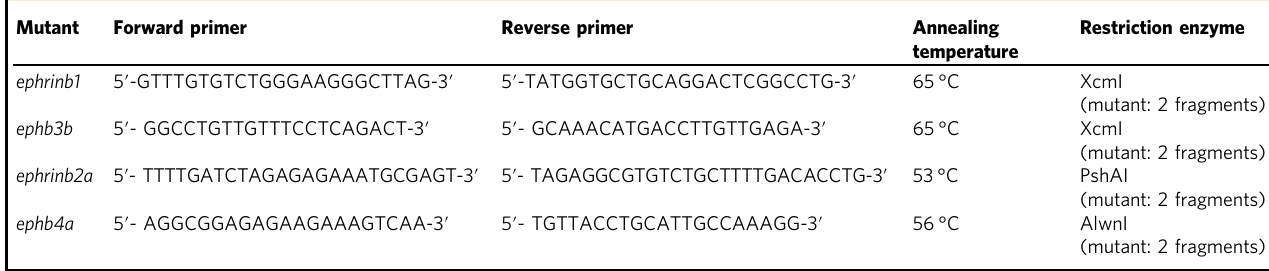
Table 2 PCR and restriction digest information for mutant